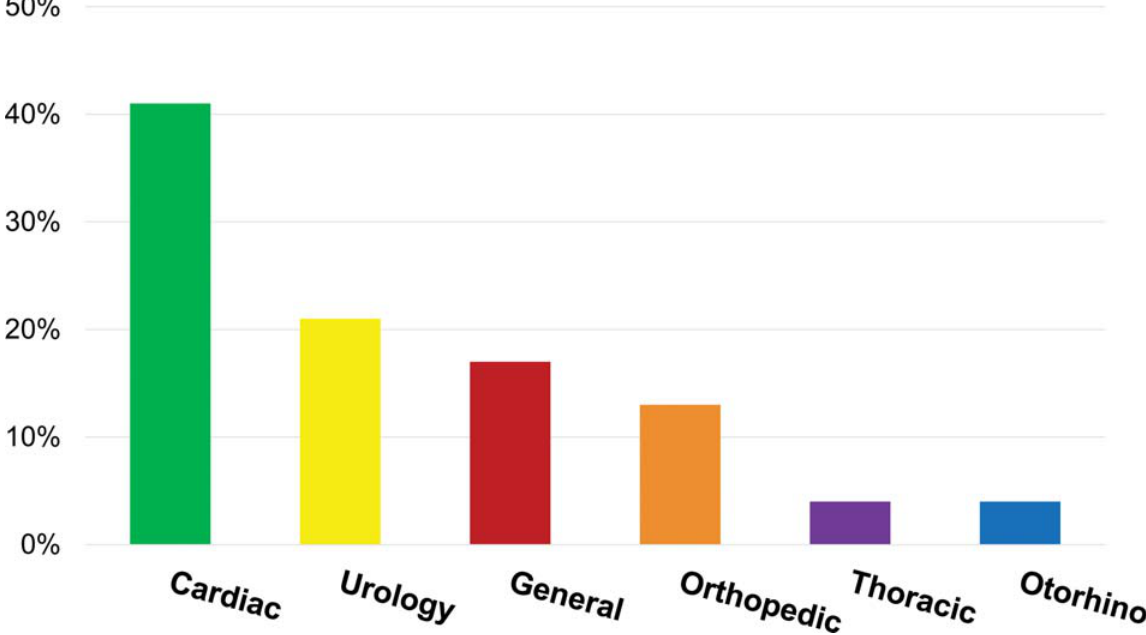
Fig. 3 Nondeferrable, intermediate-high bleeding risk surgeries included in the studied patient population undergoing bridging with cangrelor for high ischemic